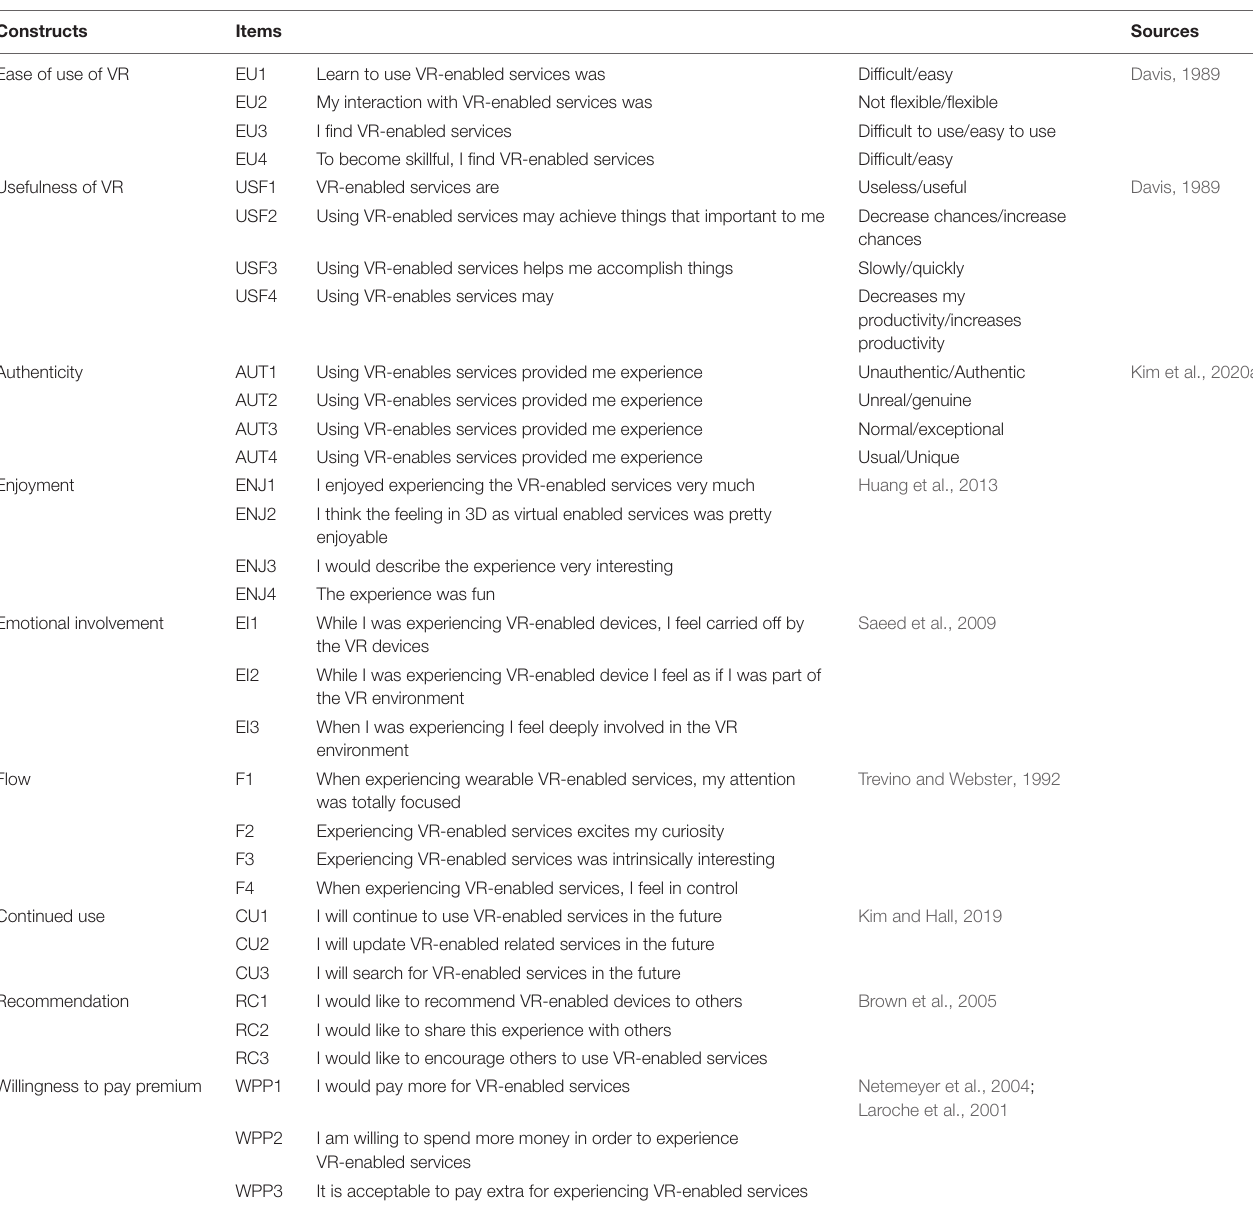
TABLE 2 | Definitions of study variables.